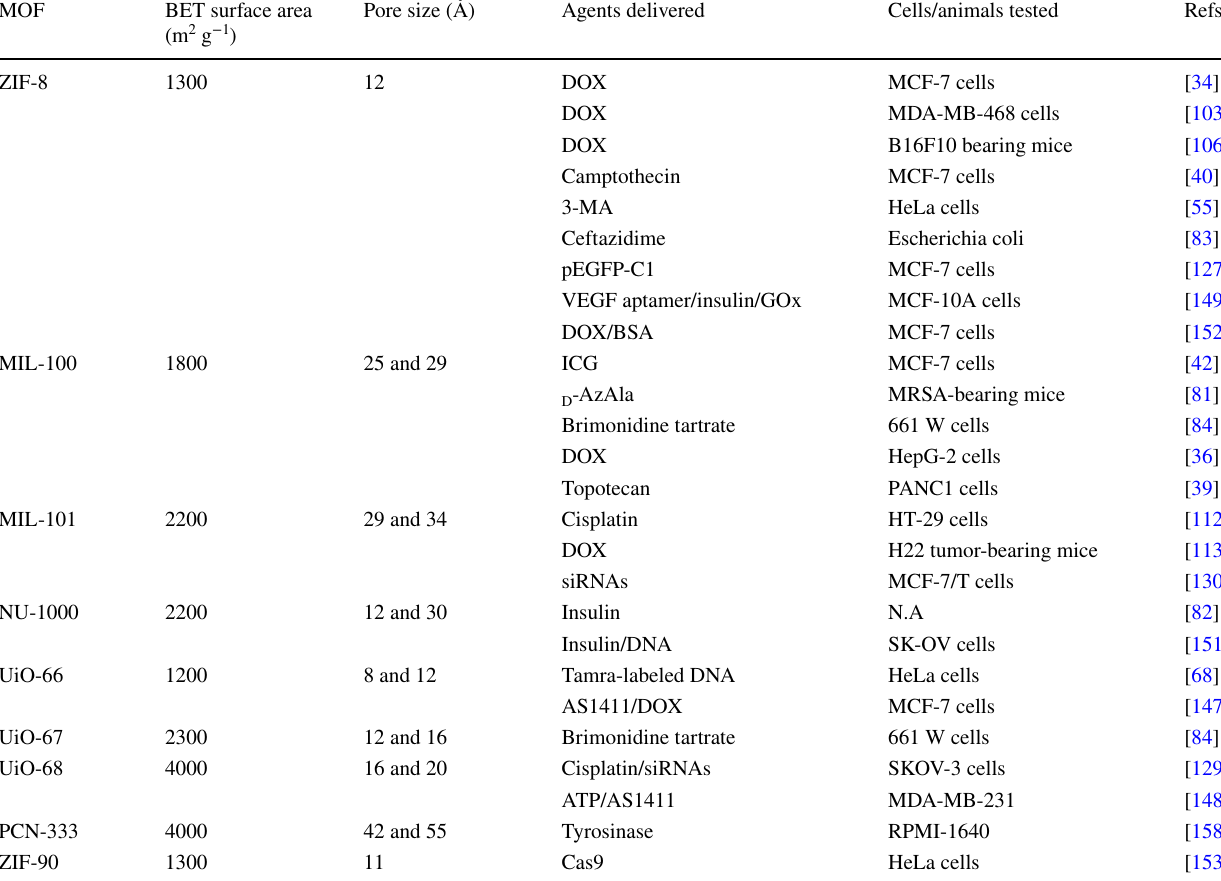
Table 2 Summary of the MOF type, surface area, pore size, agents delivered, and cells/animals tested for drug delivery discussed in this review